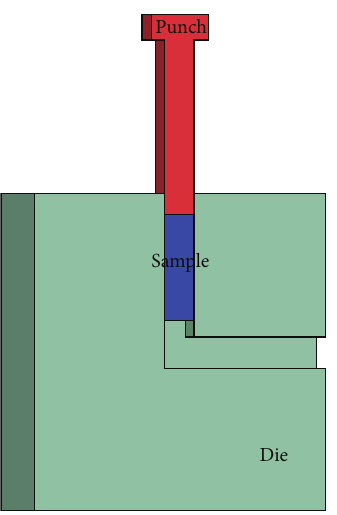
Figure 1: Schematic diagram of the